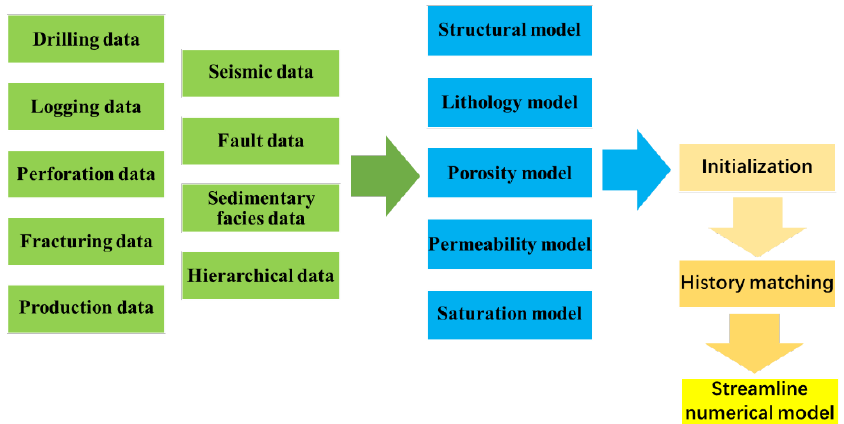
Figure 8. The flowchart of streamline model establishment.